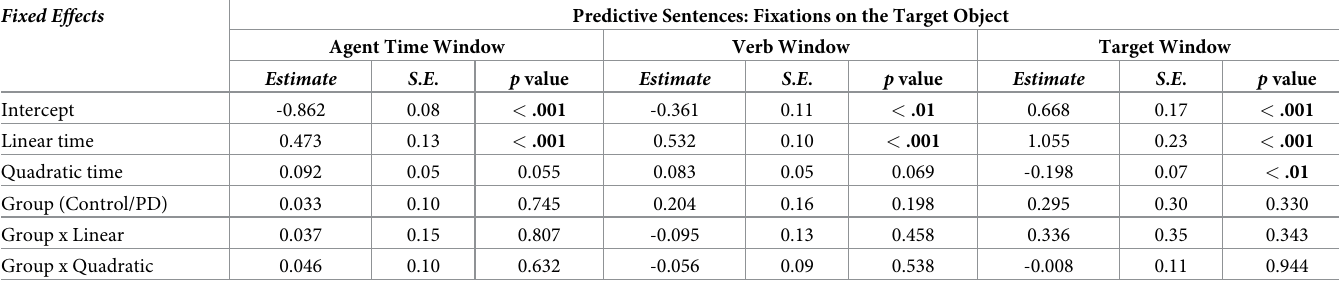
Table 2. Analyses of PD versus control gaze logits to the target object during predictive